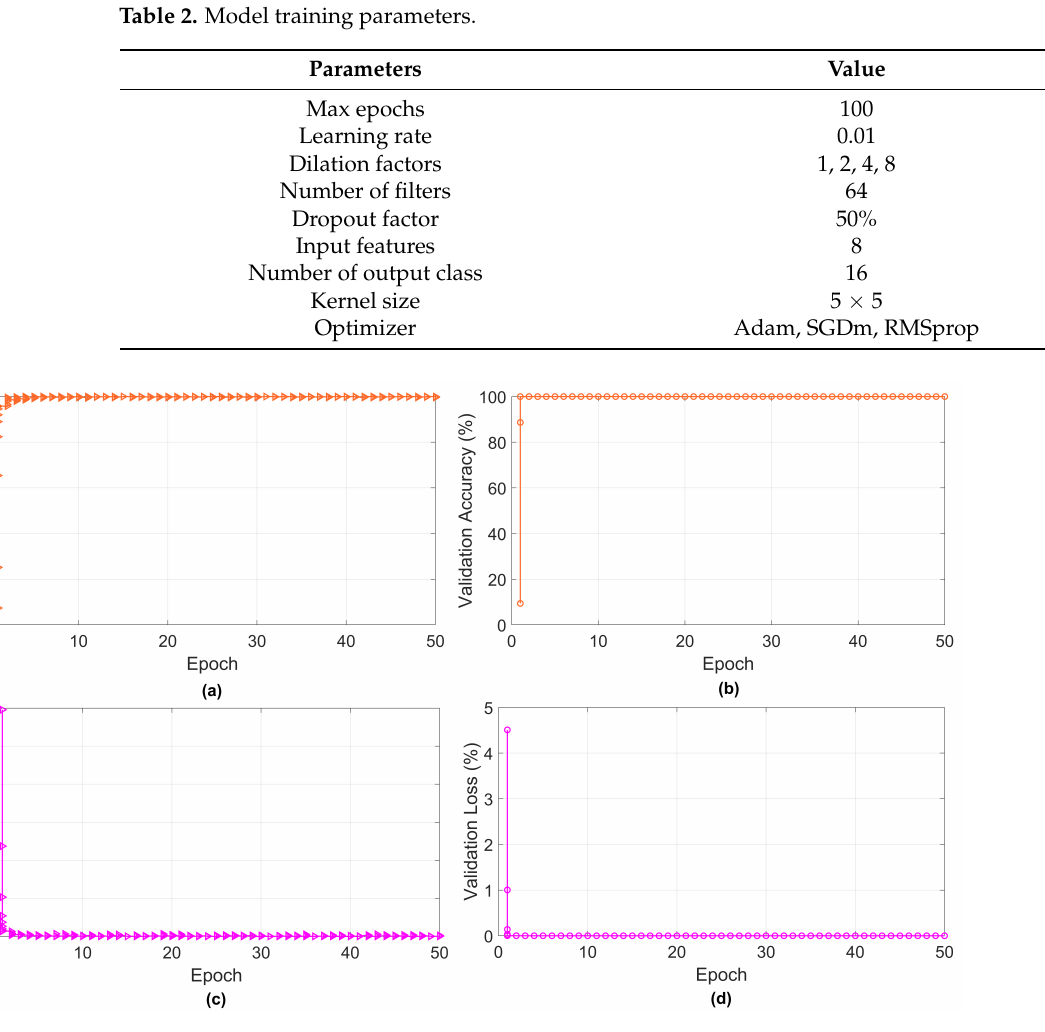
Figure 5. Training progress of proposed TCN model: ( a ) training accuracy with 50 epochs, ( b ) valida- tion accuracy with 50 epochs, ( c ) validation accuracy with 50 epochs, and ( d ) validation loss with 50